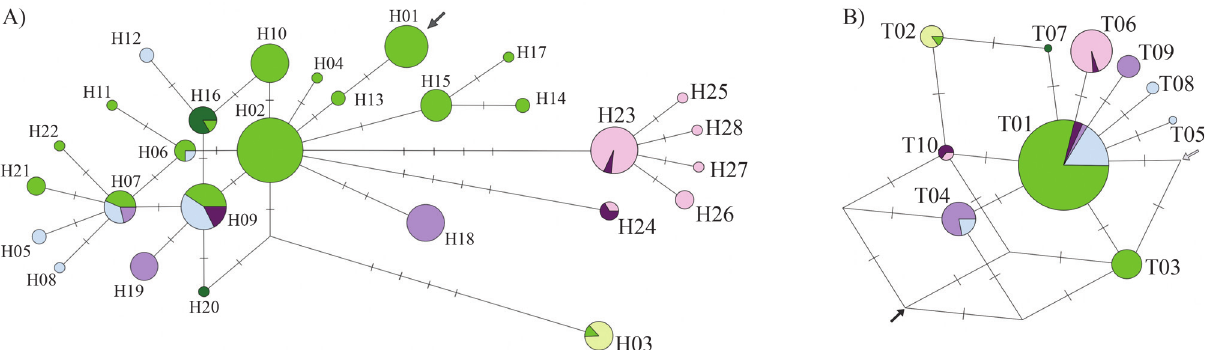
Figure 2 - Median-joining networks based on puma ND5 haplotypes. The area of each circle is proportional to the haplotype frequency. The relative fre- quency of populations in each haplotype is indicated by the proportion of different colors (coded as in Figure 1). A) Analysis of the full data set (669 bp). The arrow indicates the point where the outgroup P. yagouaroundi is connected. B) Analysis of a subset of the nucleotide sites that overlap with the Miracinonyx trumani sequence (286 bp). Arrows indicate the points where the outgroup taxa join the network: P. yagouaroundi (in gray; 32 mutational steps from the connection point), and M. trumani (in black; 19 steps from the connection